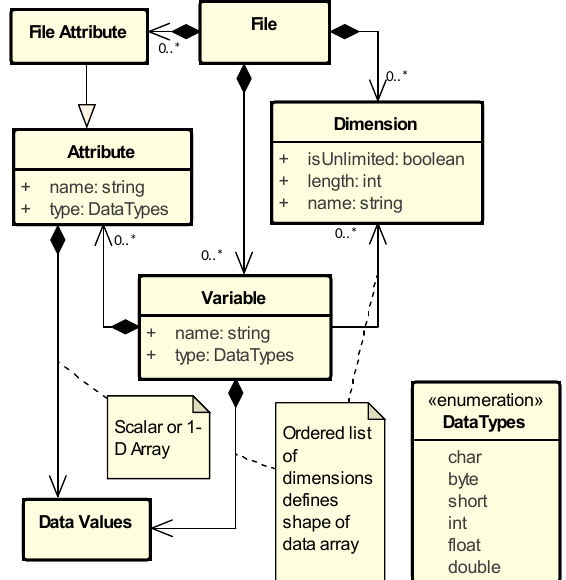
Figure 2. Key components of the netCDF classic data model (corre- sponding to the yellow “NC” layer in Fig. 1) described using UML (Appendix A). Files consist of global attributes, dimensions, and variables. Variables contain attributes and data, and attributes also contain data. Variables, attributes, and dimensions all contain prop- erties, such as a “name” which identifies them in the file. A data array has a data type for all of its elements (e.g. “double” for 64-bit floating point